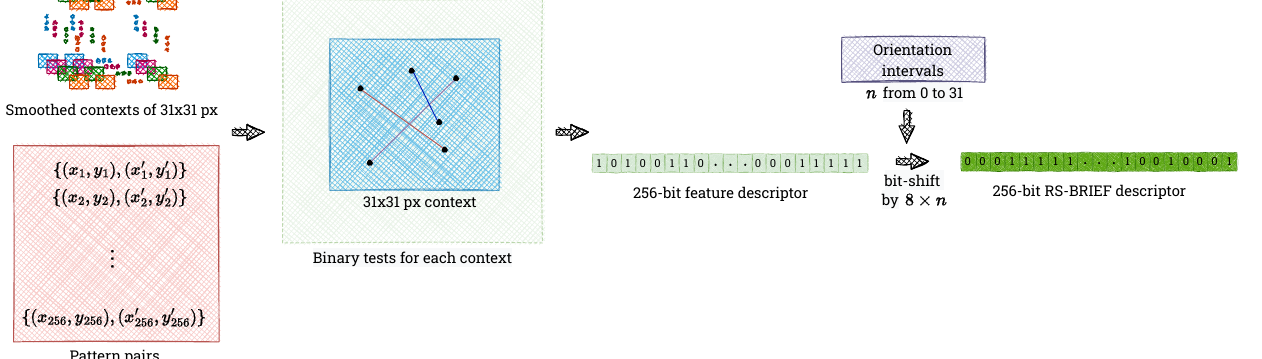
Figure 11. Scheme of the RS-BRIEF implementation. We read tests’ locations from the memory and perform comparisons between pixels’ intensities from 31 × 31 px contexts. In this way, we obtain a 256-bit feature descriptor, which we shift according to the